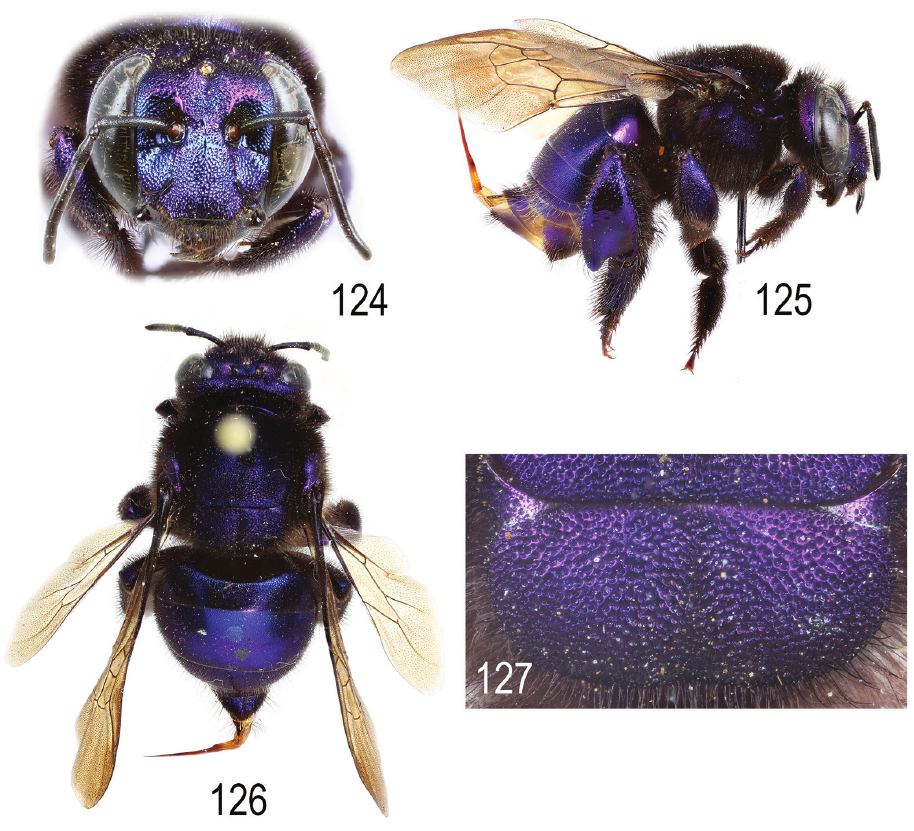
Figures 124–127. Female paratype of E. Micheneri (Mexico: Jalisco, Mascota, KUNHM-ENT 1121708). 124 Facial view 125 Lateral habitus 126 Dorsal habitus 127 Dorsal view of